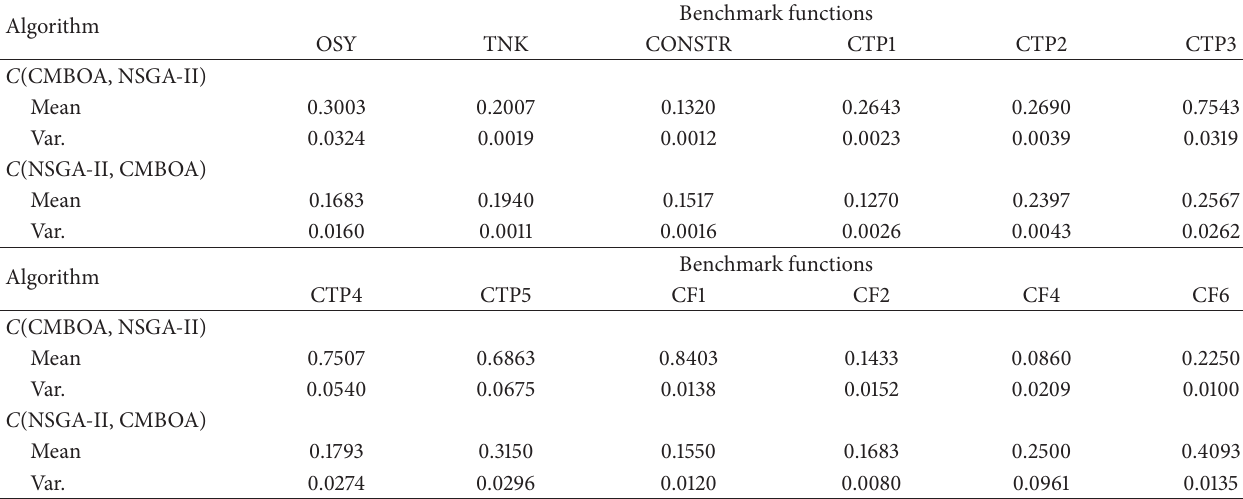
Table 1: Mean and variance (Var.) of the cover metric on CMBOA and NSGA-II.